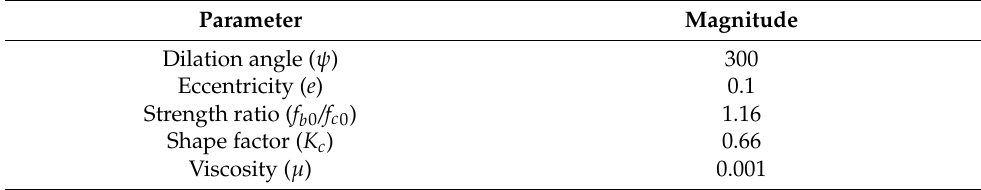
Table 3. CDP model